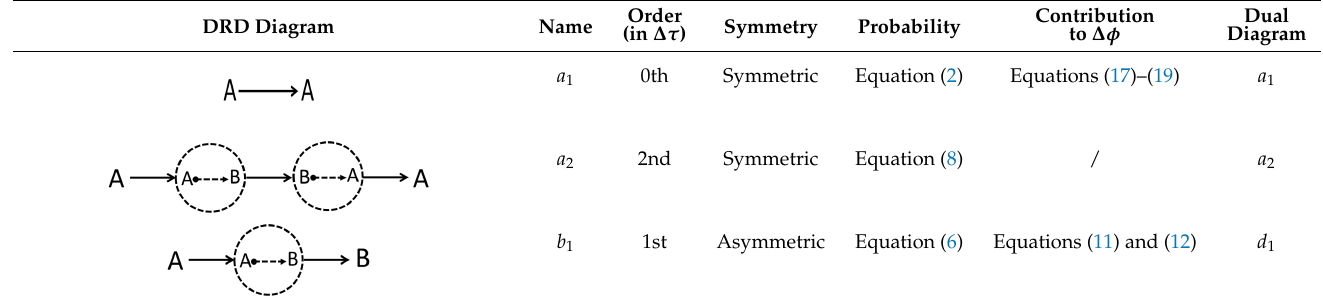
Table 1. Summary of diffusion–reaction–diffusion (DRD) diagrams of Figure 1. DRD